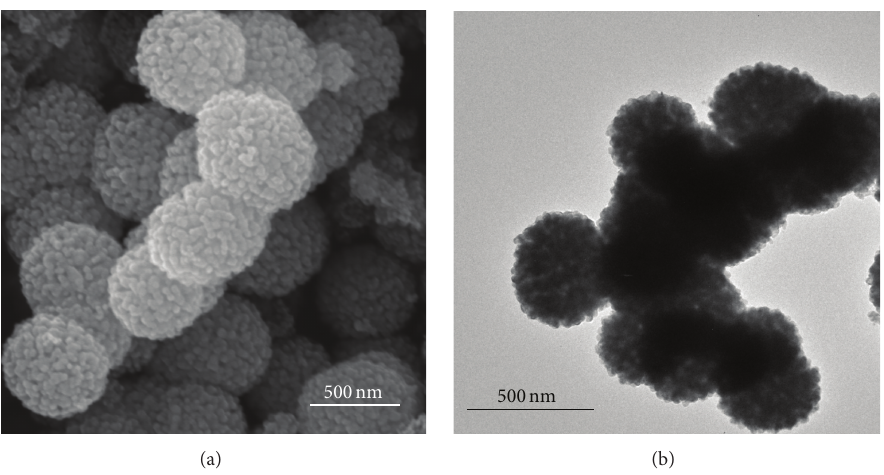
Figure 1: SEM (a) and TEM (b) of SnO 2 hollow microspheres doped with 1.5%